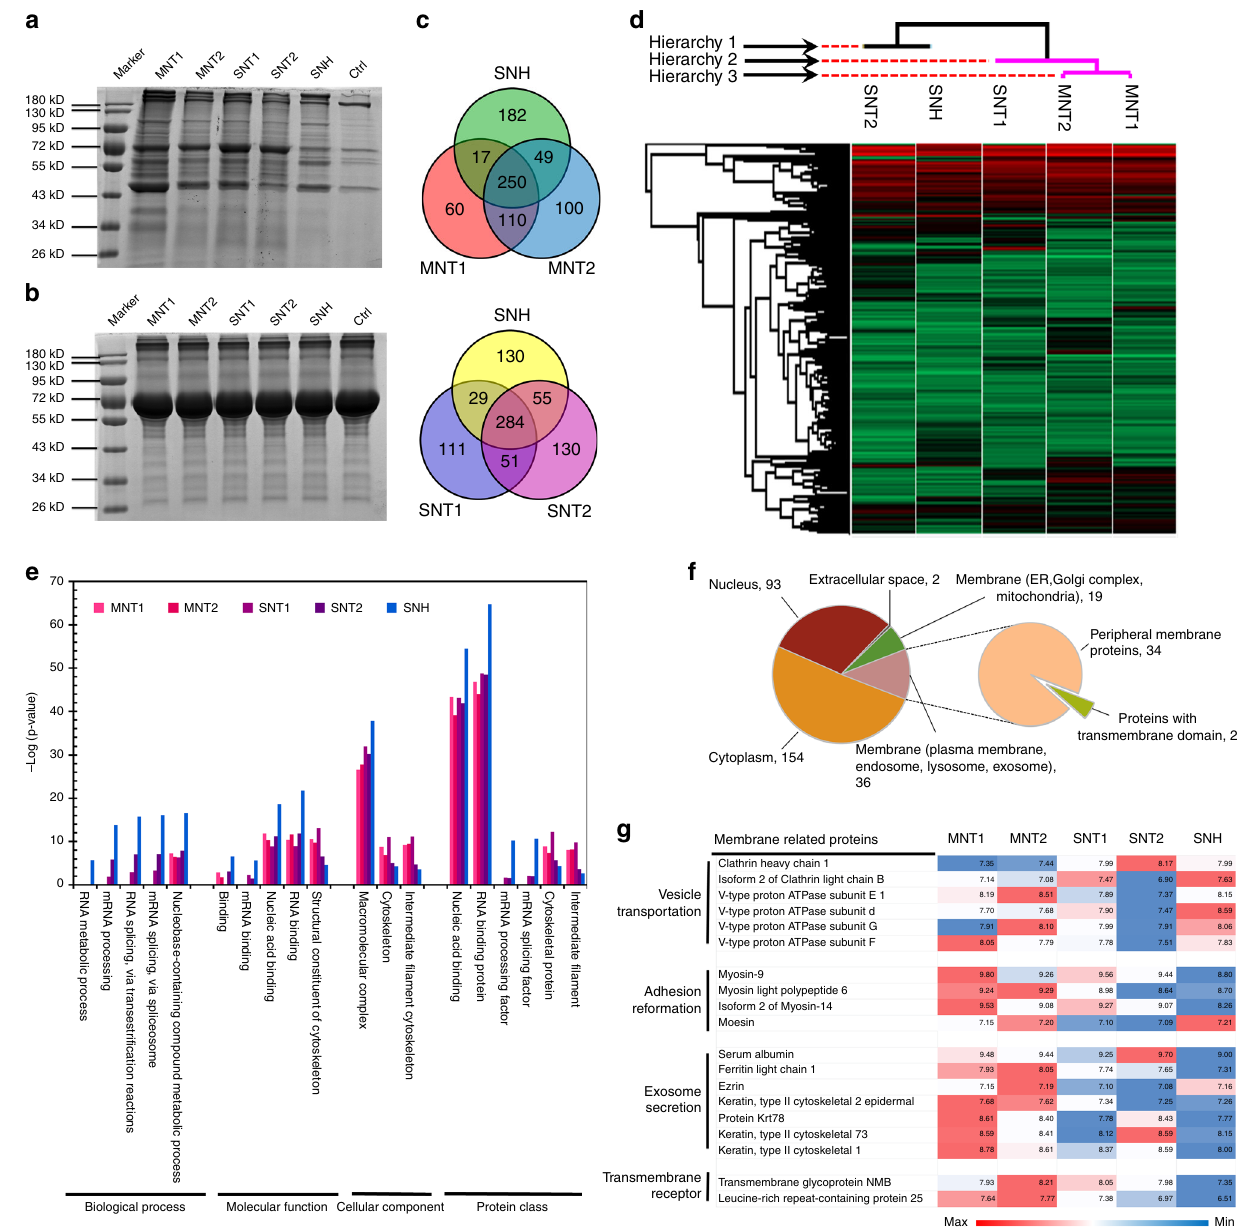
Fig. 8 Difference in nano-protein interaction between SNH and CNT. a Gel electropherogram of cellular proteins that bound with different nanocarbons after cell lysate incubations. The resultant stripes revealed the high af fi nities of part intracellular proteins with nanocarbons. b Gel electropherogram of different nanocarbon dispersions that contained 0.5% bovine serum albumin (BSA). c Venn diagrams of identi fi ed proteins among different nanocarbon groups. SNH shared near half of proteins with MNT and SNT separately. d Hierarchical clustering analysis of af fi nitive proteins among fi ve nanocarbon groups, revealing the distinctions of SNH with CNT in protein class. e Overrepresentation (OR) tests of af fi nitive proteins in different nanocarbon groups based on gene ontology (GO) analysis. f Intracellular distribution of shared af fi nitive proteins for fi ve nanocarbon groups. g Protein-binding abundance comparisons among different nanocarbon groups via heat mapping analysis. The values in heat map indicated the logarithmic intensities of proteins based on label-free quanti fi cation (LFQ) detected by